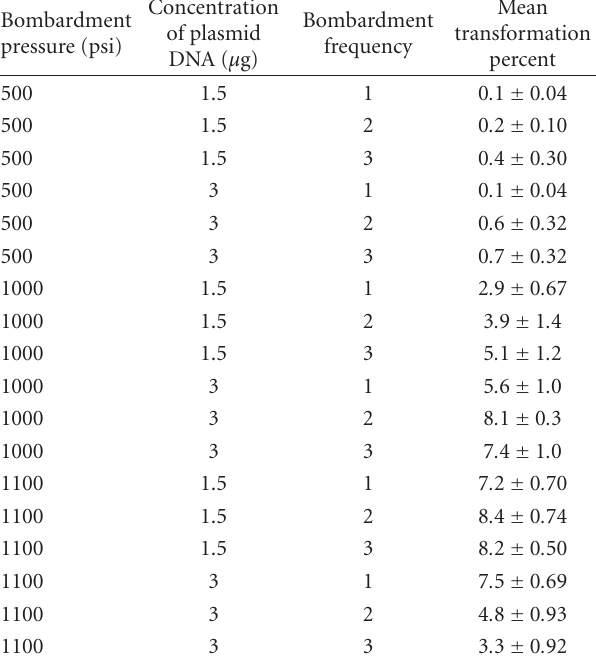
Table 1: Transient expression of GUS using di ff erent gene gun pressure (psi), DNA plasmid concentration and bombardment frequency for optimizing the Biolistic bombardment conditions for the pCATIF containing the gus